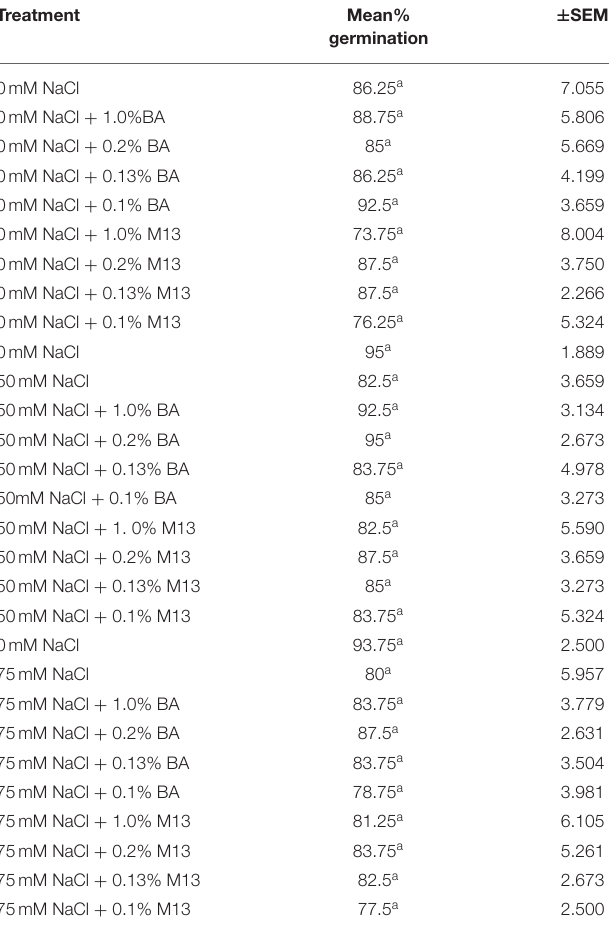
TABLE 4 | Effect of treatment on mean percentage germination of soybean exposed to 0, 50, and 75mM NaCl, for 48h. Treatment